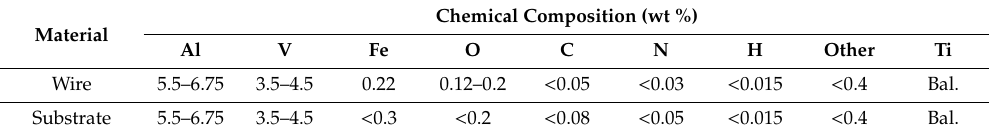
Table 1. Nominal composition of welding wire and